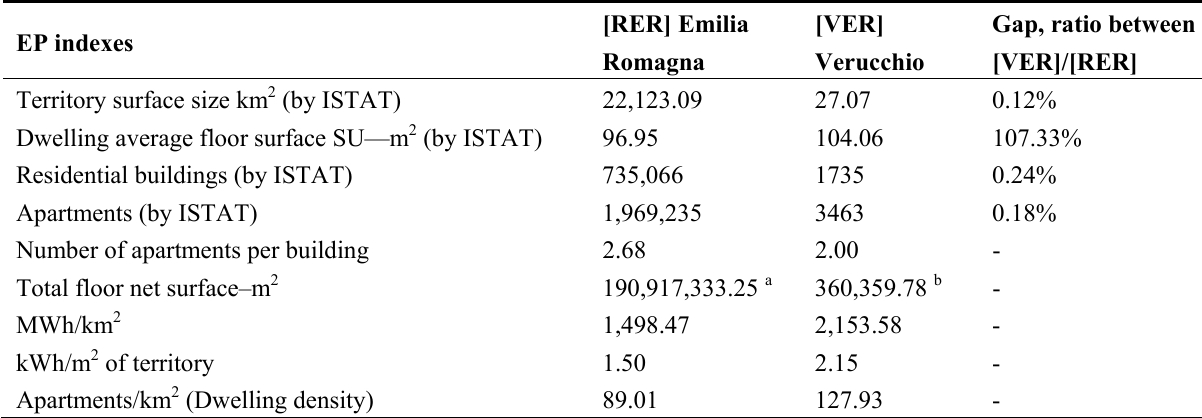
Table 4. Statistical data of Emilia-Romagna Region and Verucchio town.